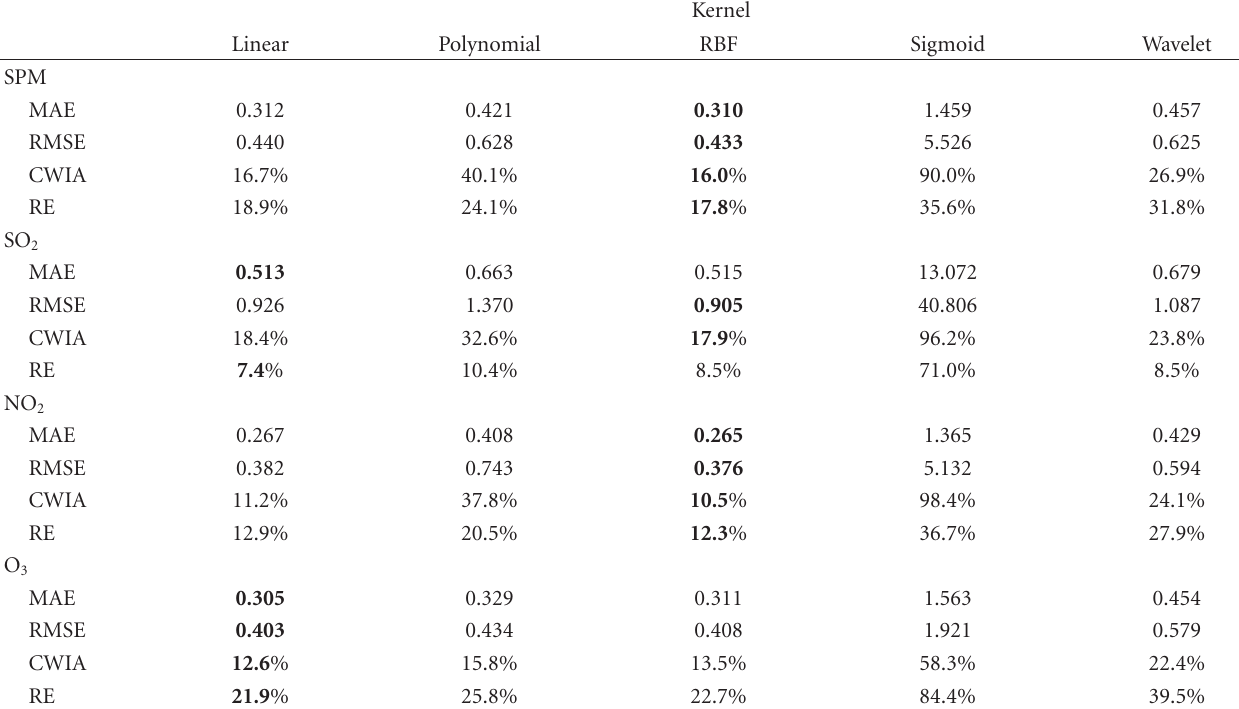
Table 4: The tested results of SPM, SO 2 , NO 2 , and O 3 in di ff erent kernel models in 1-year experiment.